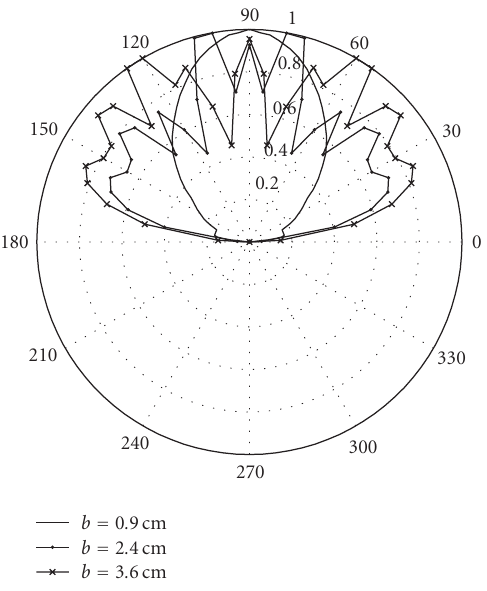
Figure 5: E -plane pattern for l = 2 . 25, 3.0, and 3.75 cm. Figure 6: E -plane patterns for b = 0 . 9, 2.4, and 3.6 cm.